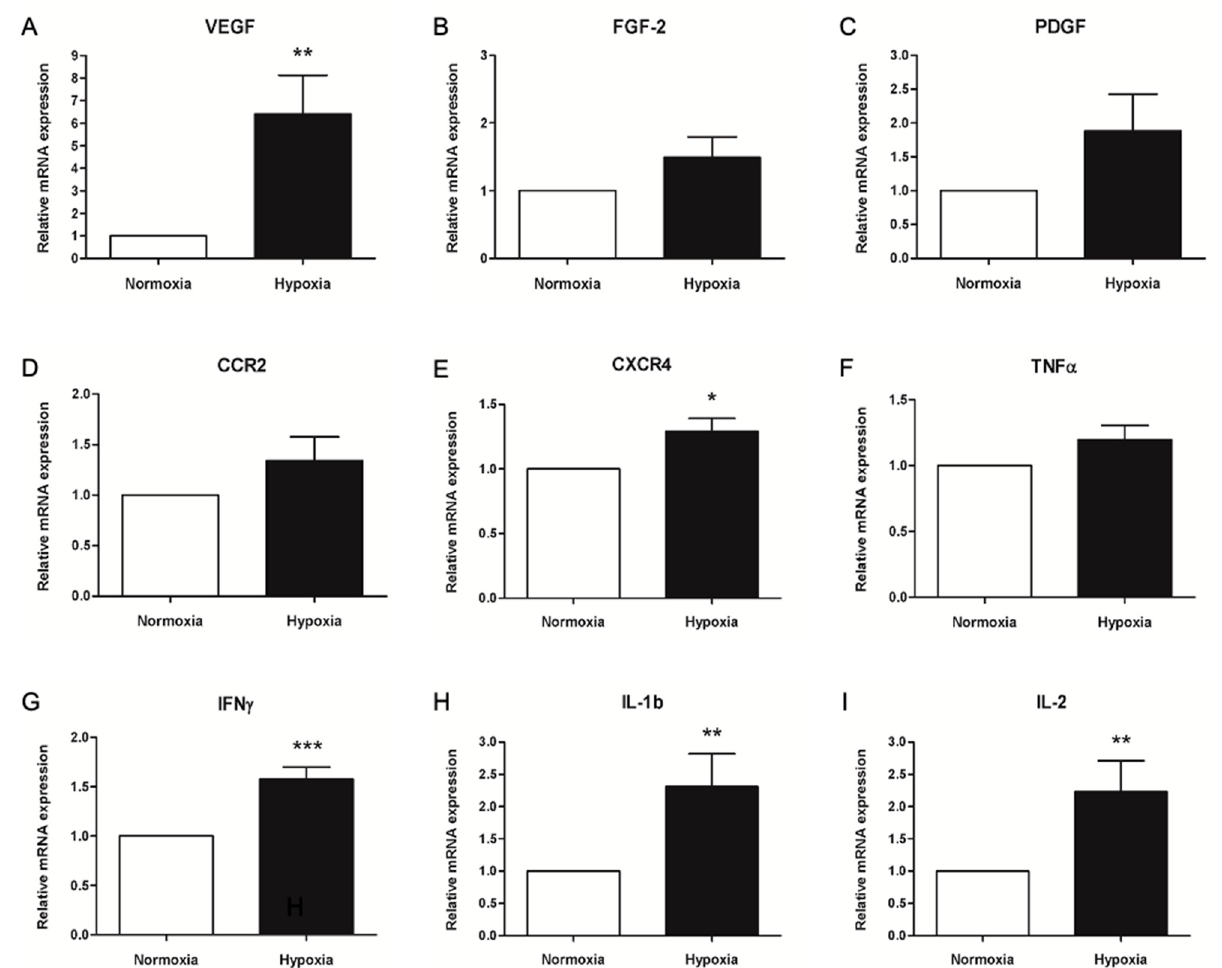
Figure 4. Relative quantification of mRNA expression in normoxic (control) and hypoxic cultures obtained by quantitative RT-PCR. β -actin was used as housekeeping gene. ( A ) Relative expression of ( A ) VEGF-A, ( B ) FGF-2, ( C ) PDGF, ( D ) CCR2, ( E ) CXCR4, ( F ) TNF- α , ( G ) IFN- γ , ( H ) IL-1 β and ( I ) IL-2 genes. Values are normalized to normoxic controls with the ⊗⊗ CT method. Data are represented as mean ± SEM from triplicate determinations, N = 8. * = p < 0.05, ** = p < 0.01, *** = p <